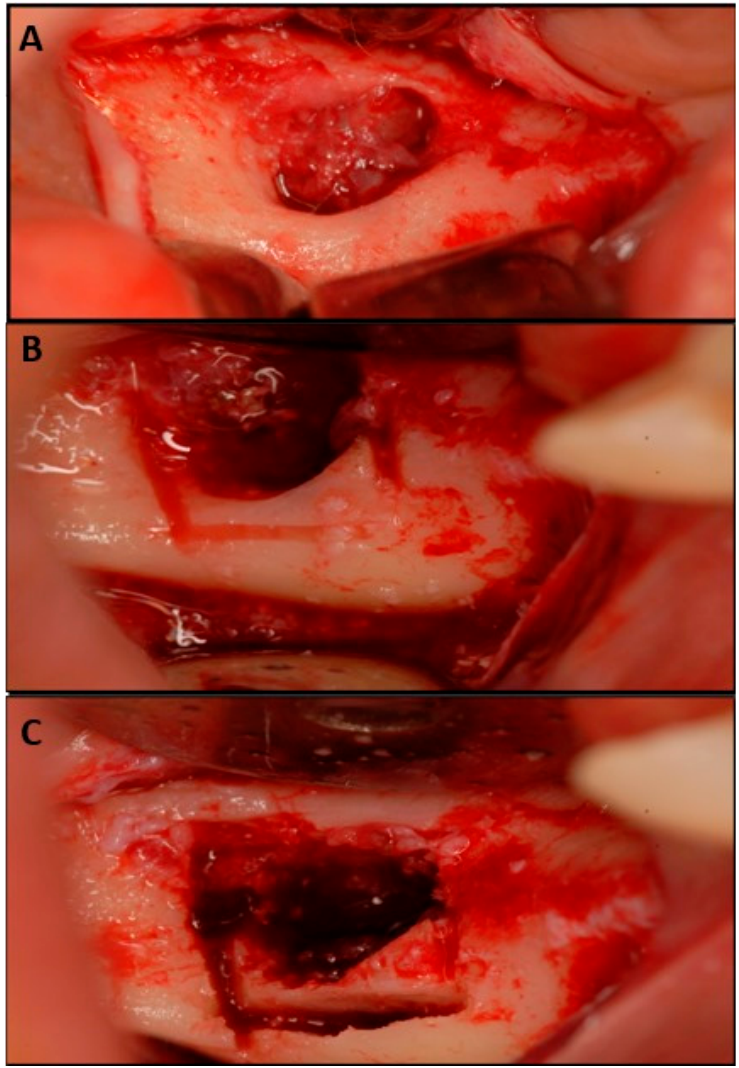
Figure 10. ( A ) Surgical site after incision; ( B ) Delimitation with piezo surgery; ( C ) Bone plug removed with piezo surgery only.